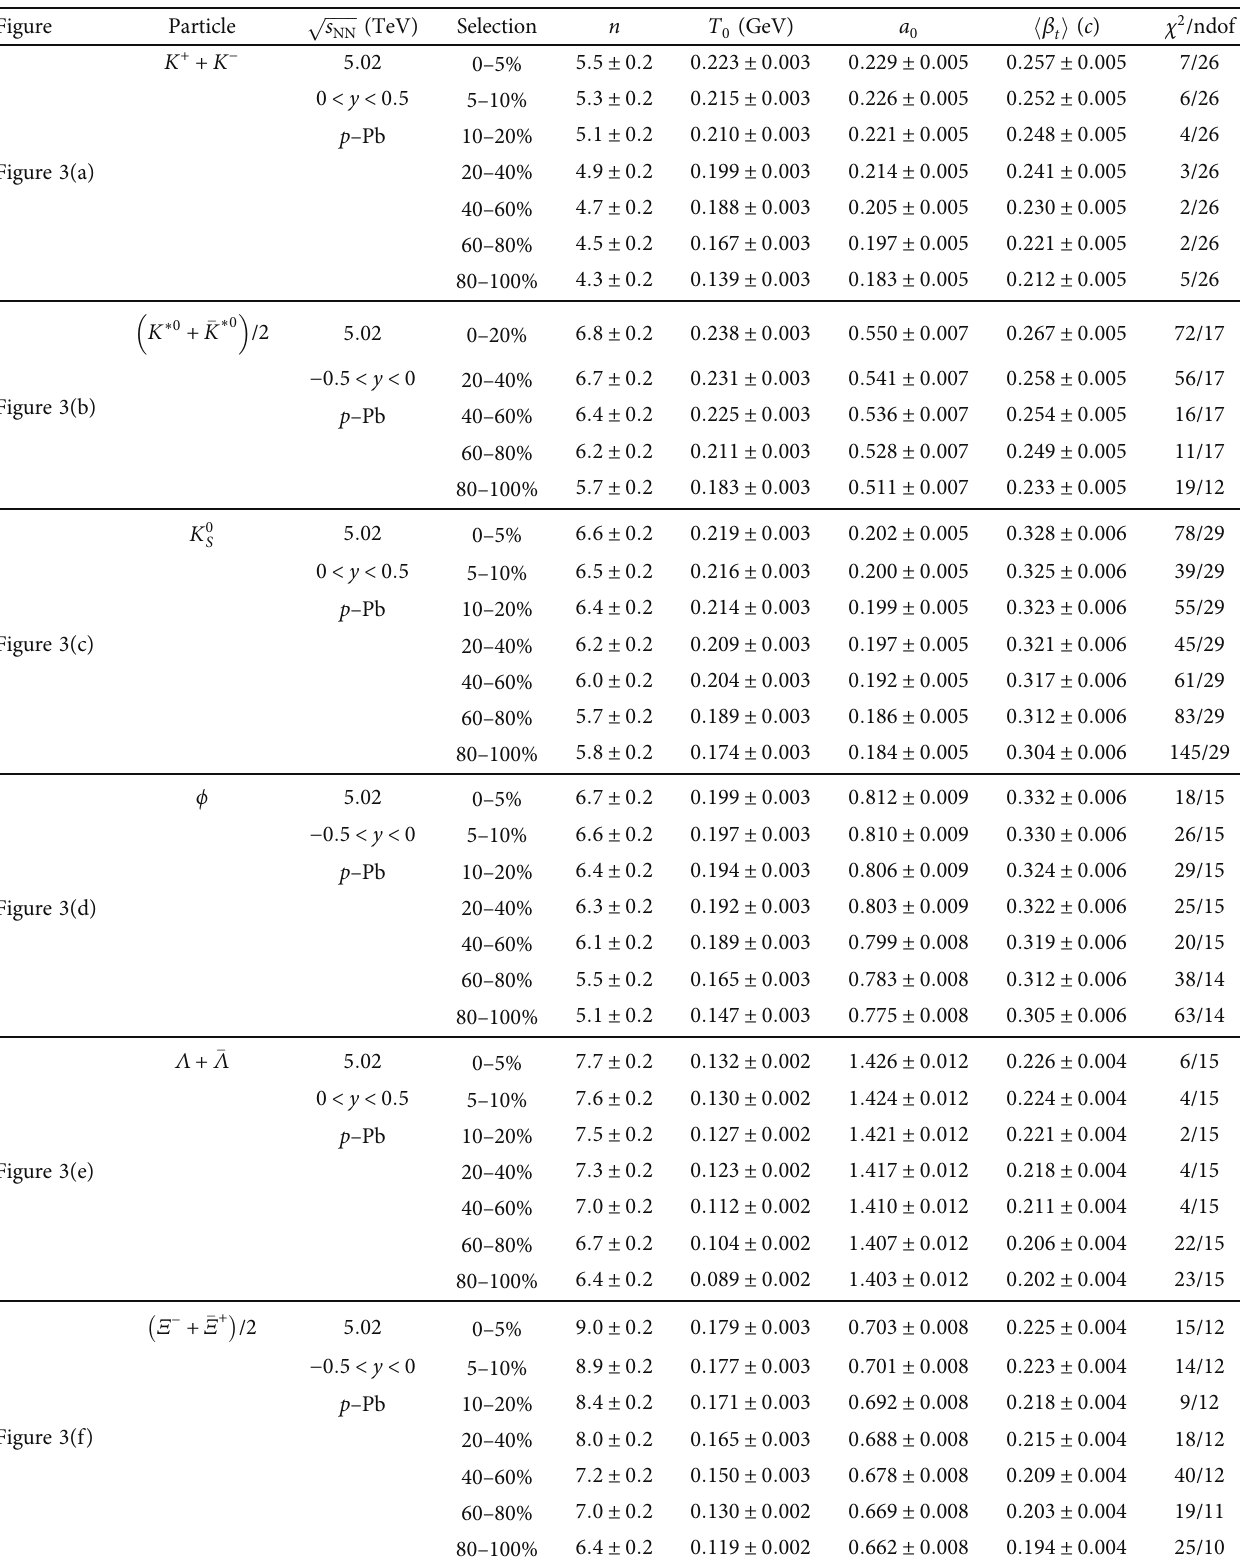
Table 3: Values of n , T